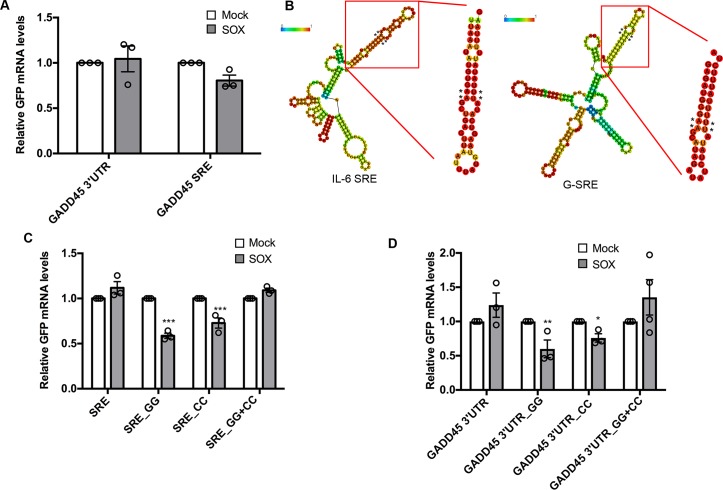
The SREs contain a long hairpin required for protection against SOX.(A) 293T cells were transfected with the indicated GFP reporter along with a control empty vector (mock) or a plasmid expressing SOX. After 24 h, total RNA was harvested and subjected to RT-qPCR to measure GFP mRNA levels. (B) Diagram of the structure prediction obtained with RNAfold for IL-6 and GADD45B SREs. The color scale represents the confidence score of the structure as calculated by RNAfold, with red representing the highest confidence. Asterisks denote the location of mutations that were introduced in the structure for the following assays. The insets are RNAfold predictions of the stem loops of interest in isolation. (C) 293T cells were transfected with the indicated GFP reporters containing mutations within IL-6 SRE at the residues marked by a * in (B) along with a control empty vector (mock) or a plasmid expressing SOX. After 24 h, total RNA was harvested and subjected RT-qPCR to measure GFP mRNA levels. (D) 293T cells were transfected with the indicated GFP reporters mutated within G- SRE at the residues marked by a * in (B) along with a control empty vector (mock) or a plasmid expressing SOX. After 24 h, total RNA was harvested and subjected to RT-qPCR to measure GFP mRNA levels.